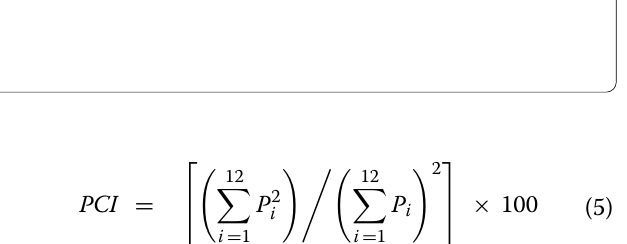
Precipitation concentration can be identified as low concentration (uniform distribution of precipitation) for PCI values lower than 10, high for values from 11 to 20 and very high for values above 21 (Oliver 1980). SRA offers insights on the occurrence and severity of drought periods. Standardized rainfall and tempera- ture anomalies have no units. They are dimensionless.